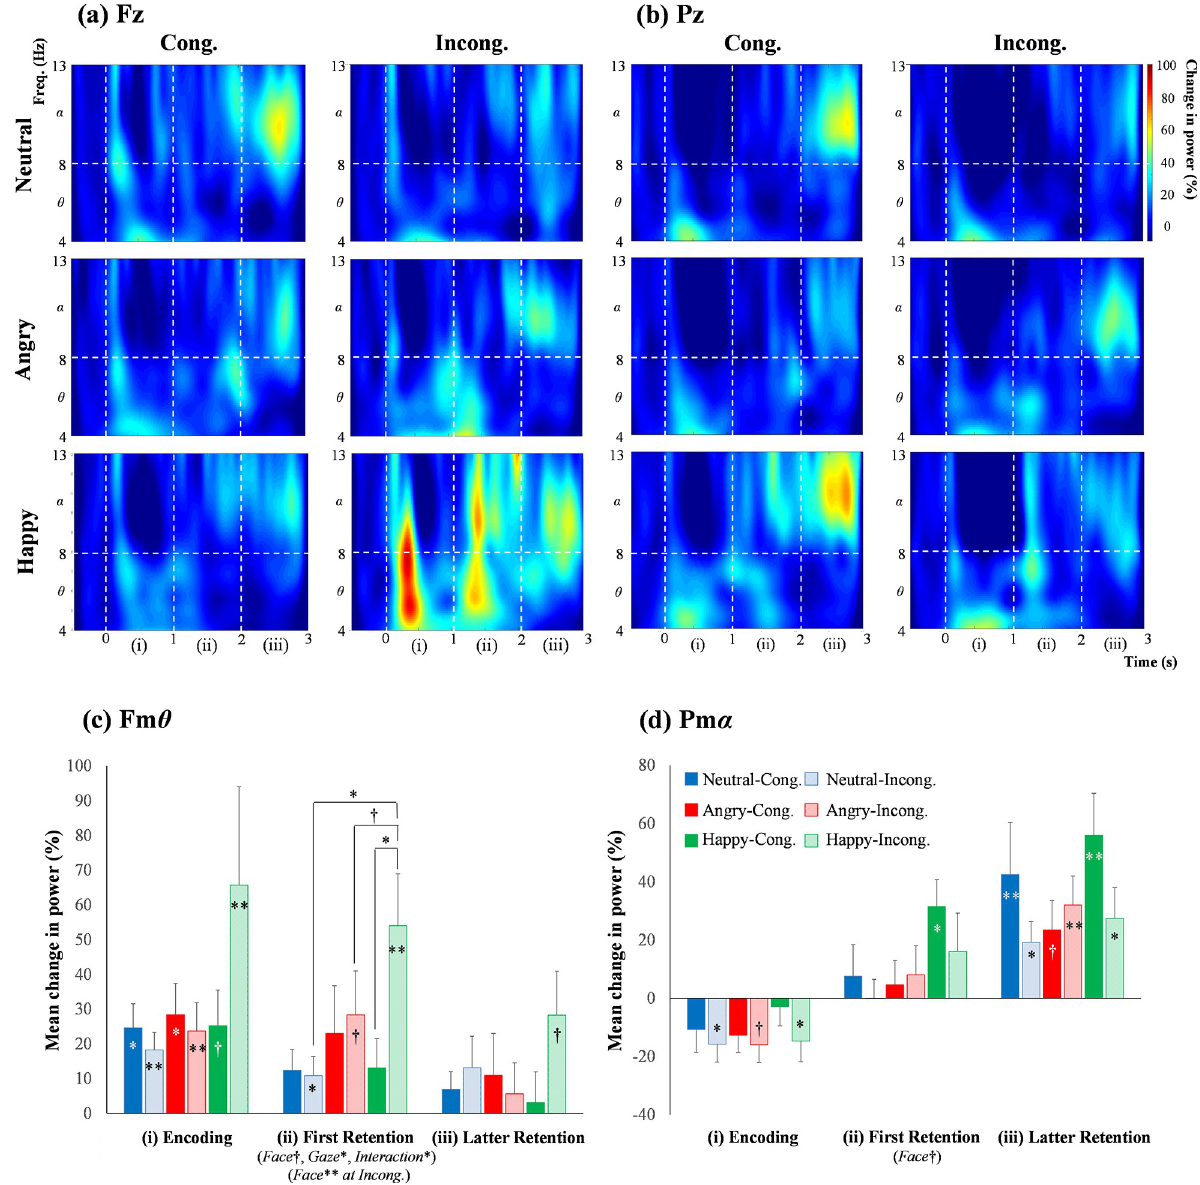
Fig 4. The time-course change in the induced θ and α powers at (a) Fz and (b) Pz sites during the working memory task for young adults. The average data with statistics for the (c) Fm θ and (d) Pm α powers in each period. The symbols are the same as those in Fig 3. neutral and happy faces [Fig 5(A)], the reaction times had a tendency toward being more delayed under the incongruent condition than the congruent condition (simple main effects of Gaze, p = .057 † for neutral faces and p = .076 † for happy faces). However, these congruency effects (i.e., incongruent minus congruent reaction times) for gaze direction did not appear for angry faces. For the Face factor under the incongruent gaze, the simple main effect was mar- ginally significant ( p = .054 † ), followed by a significant difference between angry and happy faces ( ^ p = .038). Supplementary S7 Table presents detailed information for the tests performed after the ANOVA.